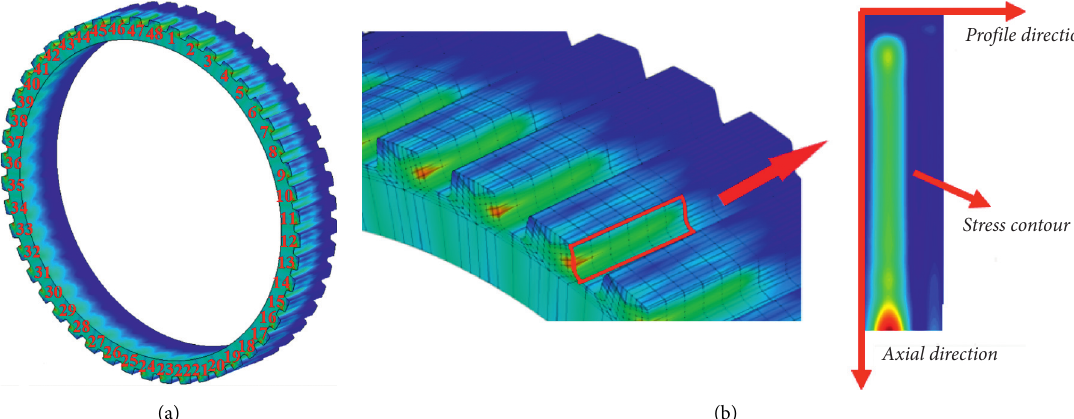
Figure 4: Stress distribution of axle spline under a certain loading case. (a) Overall contact status of axle spline. (b) Local contact surface of grids of axle spline.